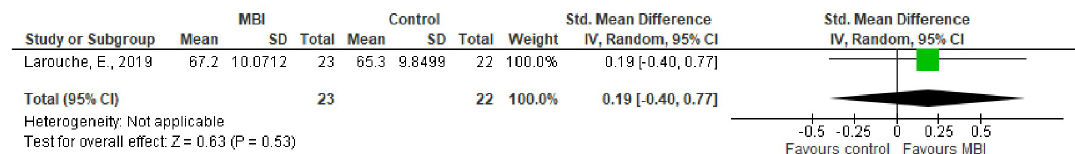
Fig 10. Forest plot of comparison: Quality of life, MBI versus control after 11 weeks to 6 months from the beginning of the intervention.